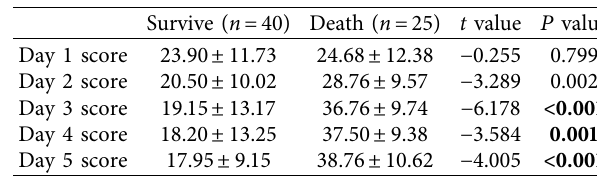
Table 3: RALE score comparison of survival and death groups in infection PARDS